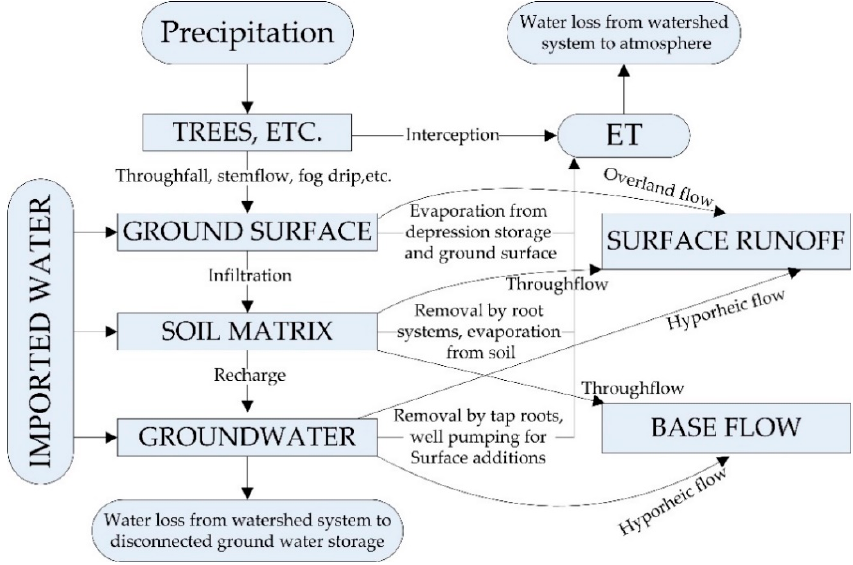
Figure 1. Process of water inputs, storage, and losses in watershed.